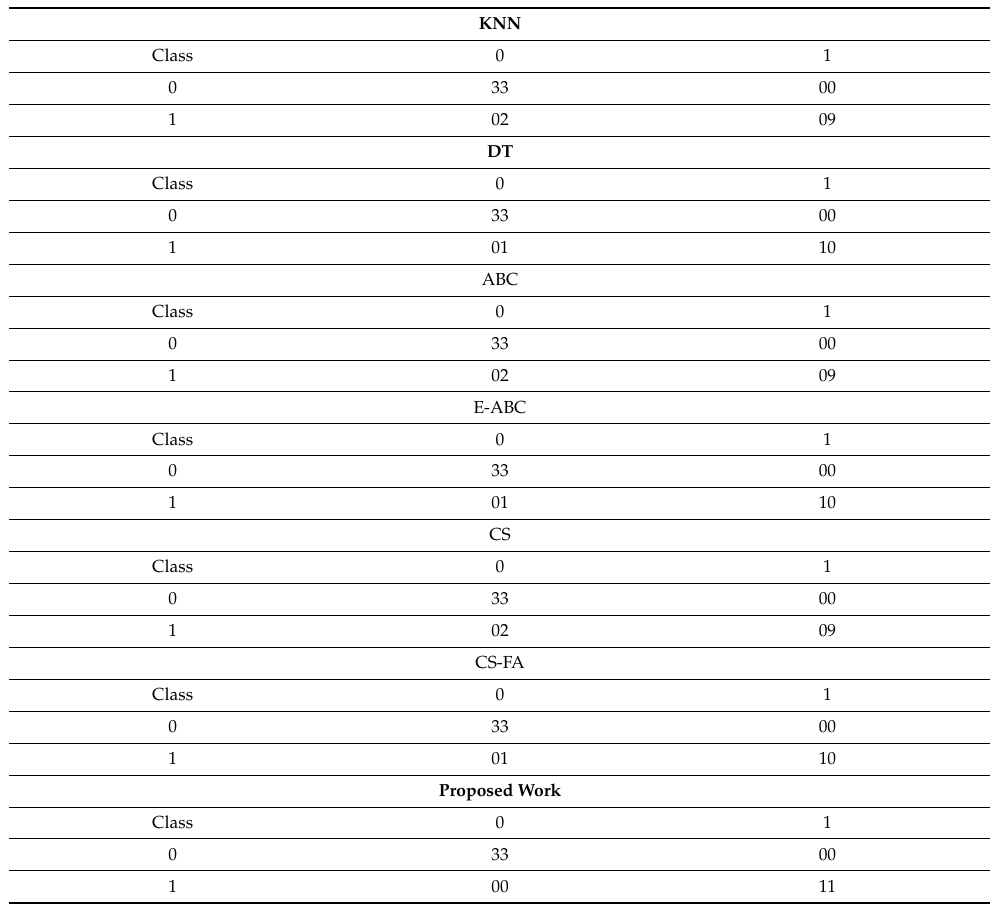
Table 5. Improvement analysis in terms of the confusion